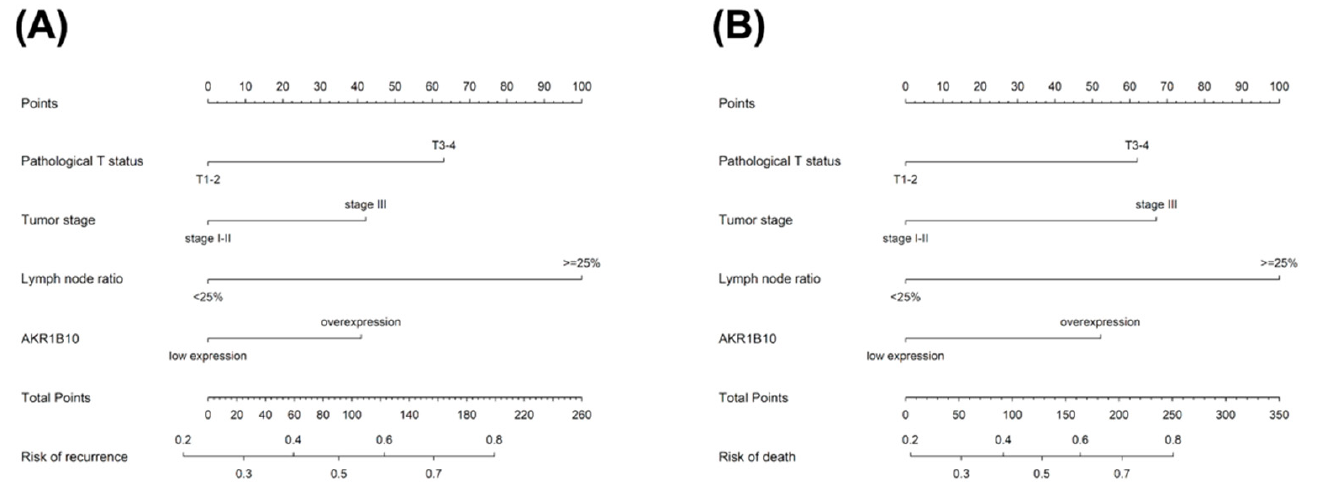
Figure 4. Nomogram predicting the risk of recurrence ( A ) and death ( B ). For each patient, corre- sponding clinicopathological feature points were calculated and summed up to obtain total points. Predicted recurrence and death could be estimated based on total points for each patient.